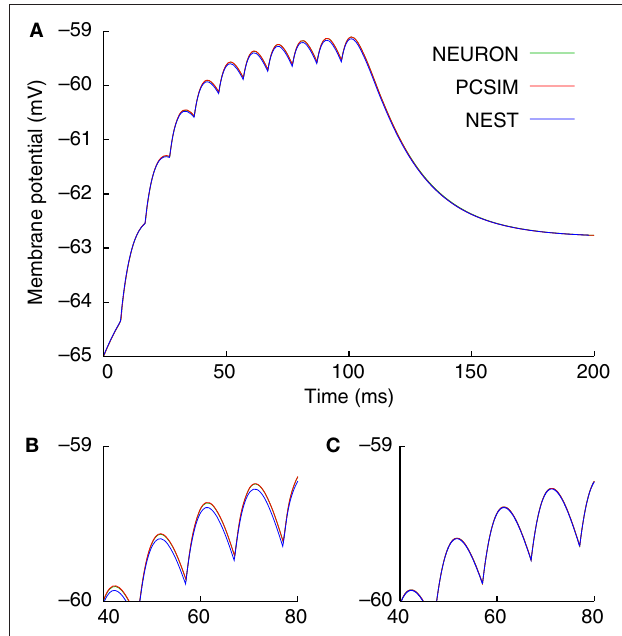
FIGURE 1 | Results of running fi rst example given in the text, with NEURON, NEST and PCSIM as back-end simulators. (A) Entire membrane potential trace with integration time-step 0.1 ms. (B) Zoom into a smaller region of the trace, showing small numerical differences between the results of the different simulators. (C) Results of a simulation with integration time-step 0.01 ms, showing greatly reduced numerical